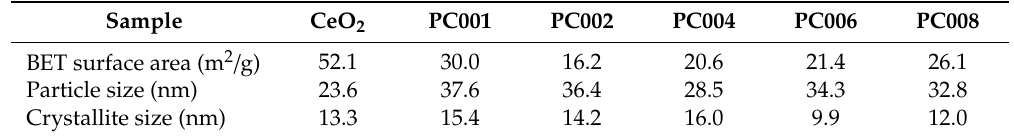
Table 1. Specific surface area (BET (Brunauer-Emmer-Teller) surface area), particle size and crystallite size of CeO 2 / PANI powders as a function of the amount of PANI